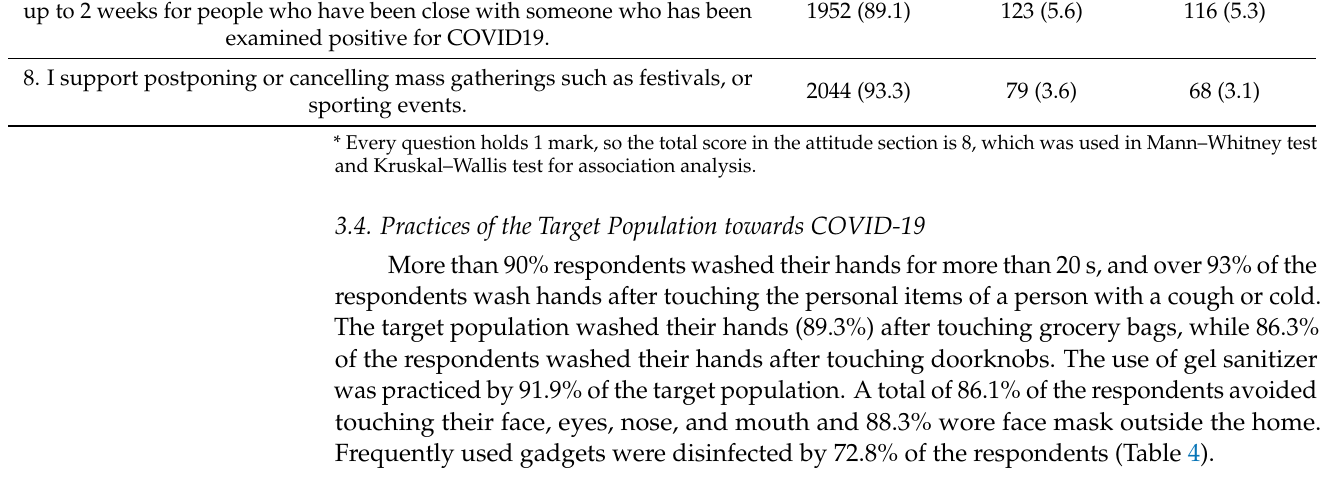
Table 4. Practices performed by the survey population to contain